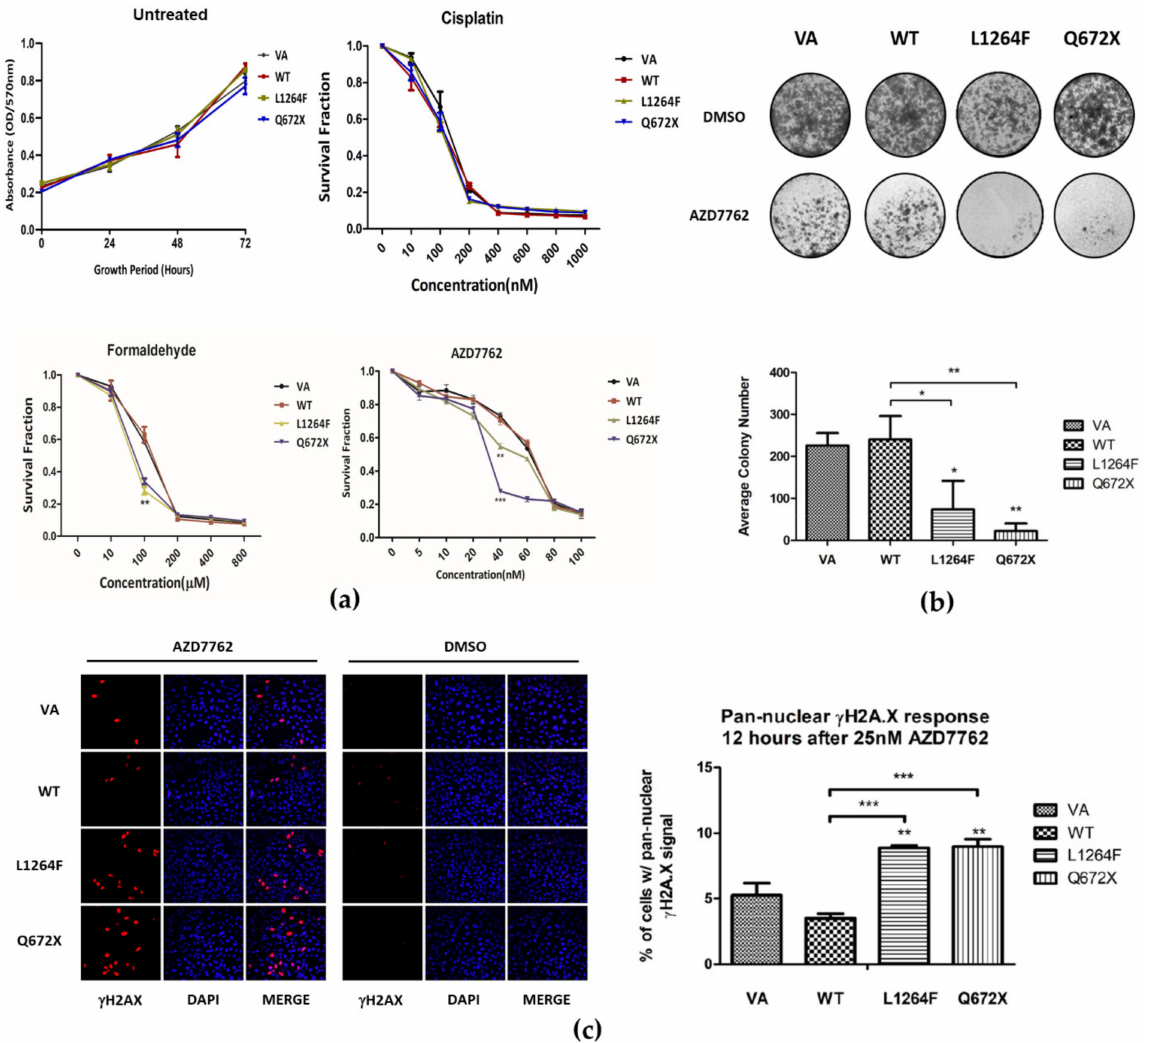
Figure 4. ( a ) Dominant negative effect of overexpression of RAD50 Q672X and RAD50 L1264F in U2OS sensitized cell viability to AZD7762 (CHK1 inhibitor) and formaldehyde treatment but not to cisplatin; ( b ) inhibited colony forming ability; and ( c ) increased pan-nuclear γ H2A.X response after AZD7762 treatment. *, **, *** indicate p < 0.05, 0.01, and 0.001,